Question: Give a one-sentence summary of this figure.
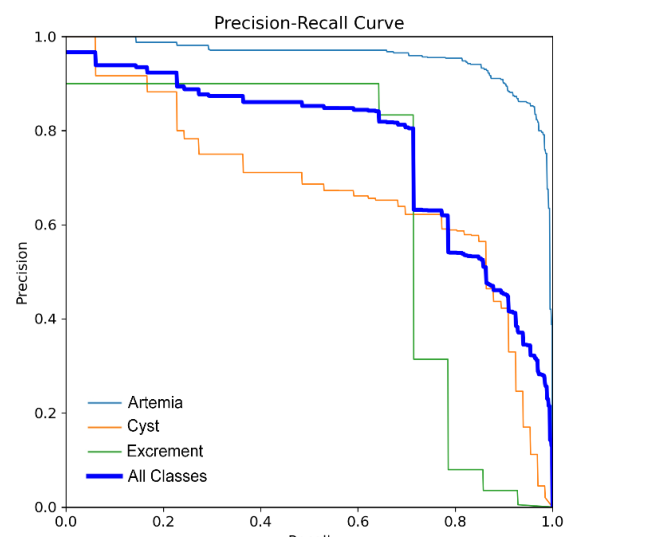
Answer: YOLOv5 Precision - Recall curve